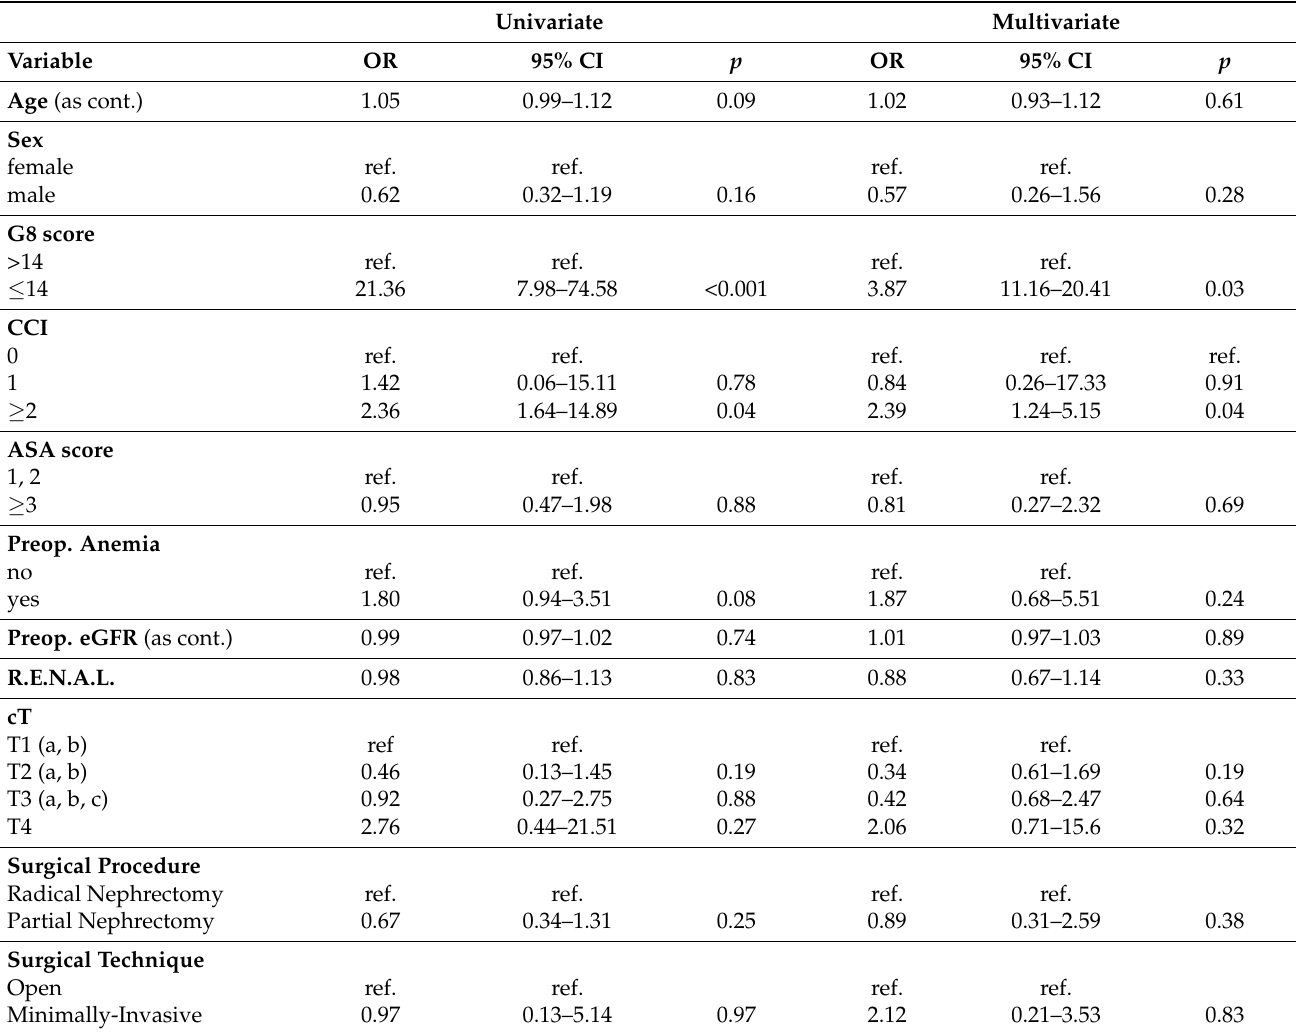
Table 2. Univariate and Multivariate Logistic Regression Analysis of factors significantly associated with perioperative complications according to Clavien-Dindo